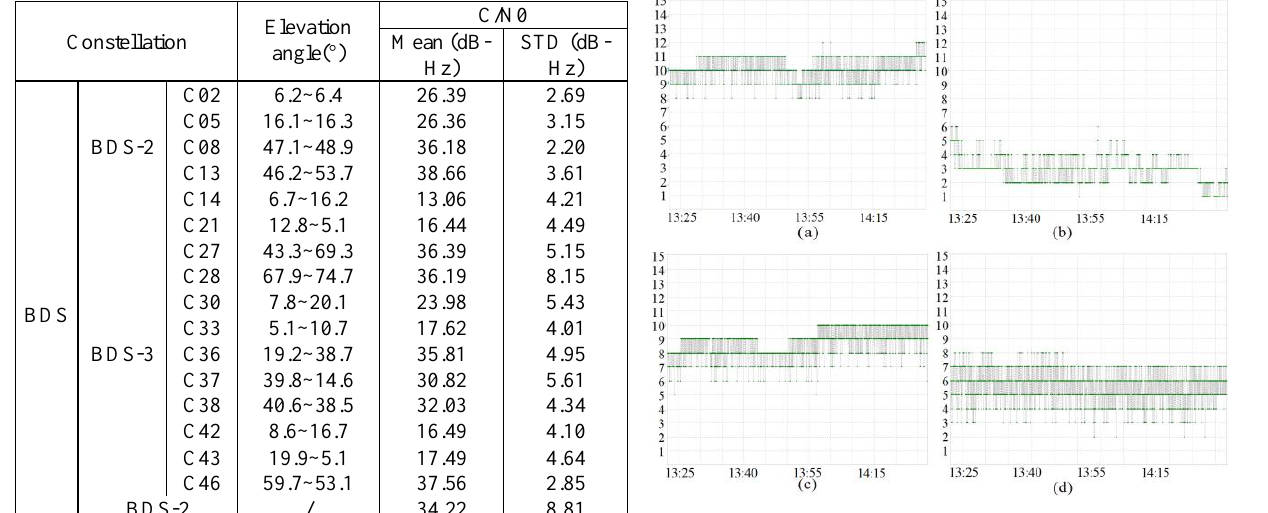
Figure 5 . The tracked satellites’ number of different constellations with elevation angles above 10° during the one- Table 3 . The mean values and standard deviations of C/N0 hour static experiment. (a) is the number of tracked satellites for measurements of BDS. BDS. (b) is the number of tracked satellites for Galileo. (c) is the number of tracked satellites for GPS. (d) is the number of tracked satellites for